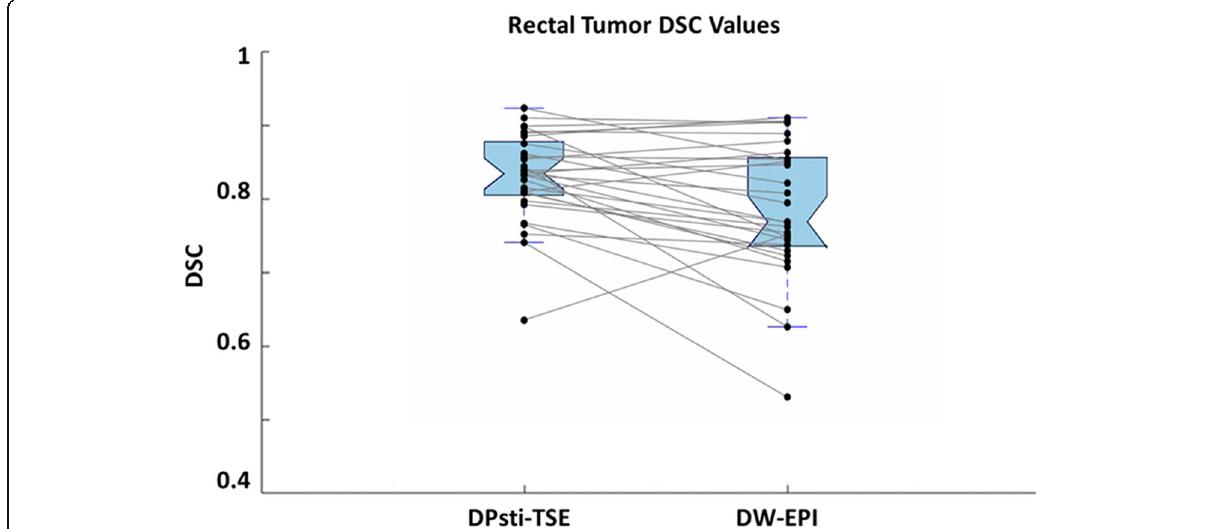
Fig. 6 Comparison of tumour region-of-interest DSC values for DPsti-TSE and DW-EPI methods. The box plots show the 75th, 50th, and 25th percentile of DSC values for all 29 patients. For the same patients, DSC values from DPsti-TSE and DW-EPI are connected. DSC values for DPsti-TSE were significantly higher than DSC values from DW-EPI ( p = 0.010). ( DPsti-TSE diffusion-prepared stimulated echo turbo spin-echo, DSC Dice similarity correlation coefficient, DW-EPI diffusion-weighted echo-planar